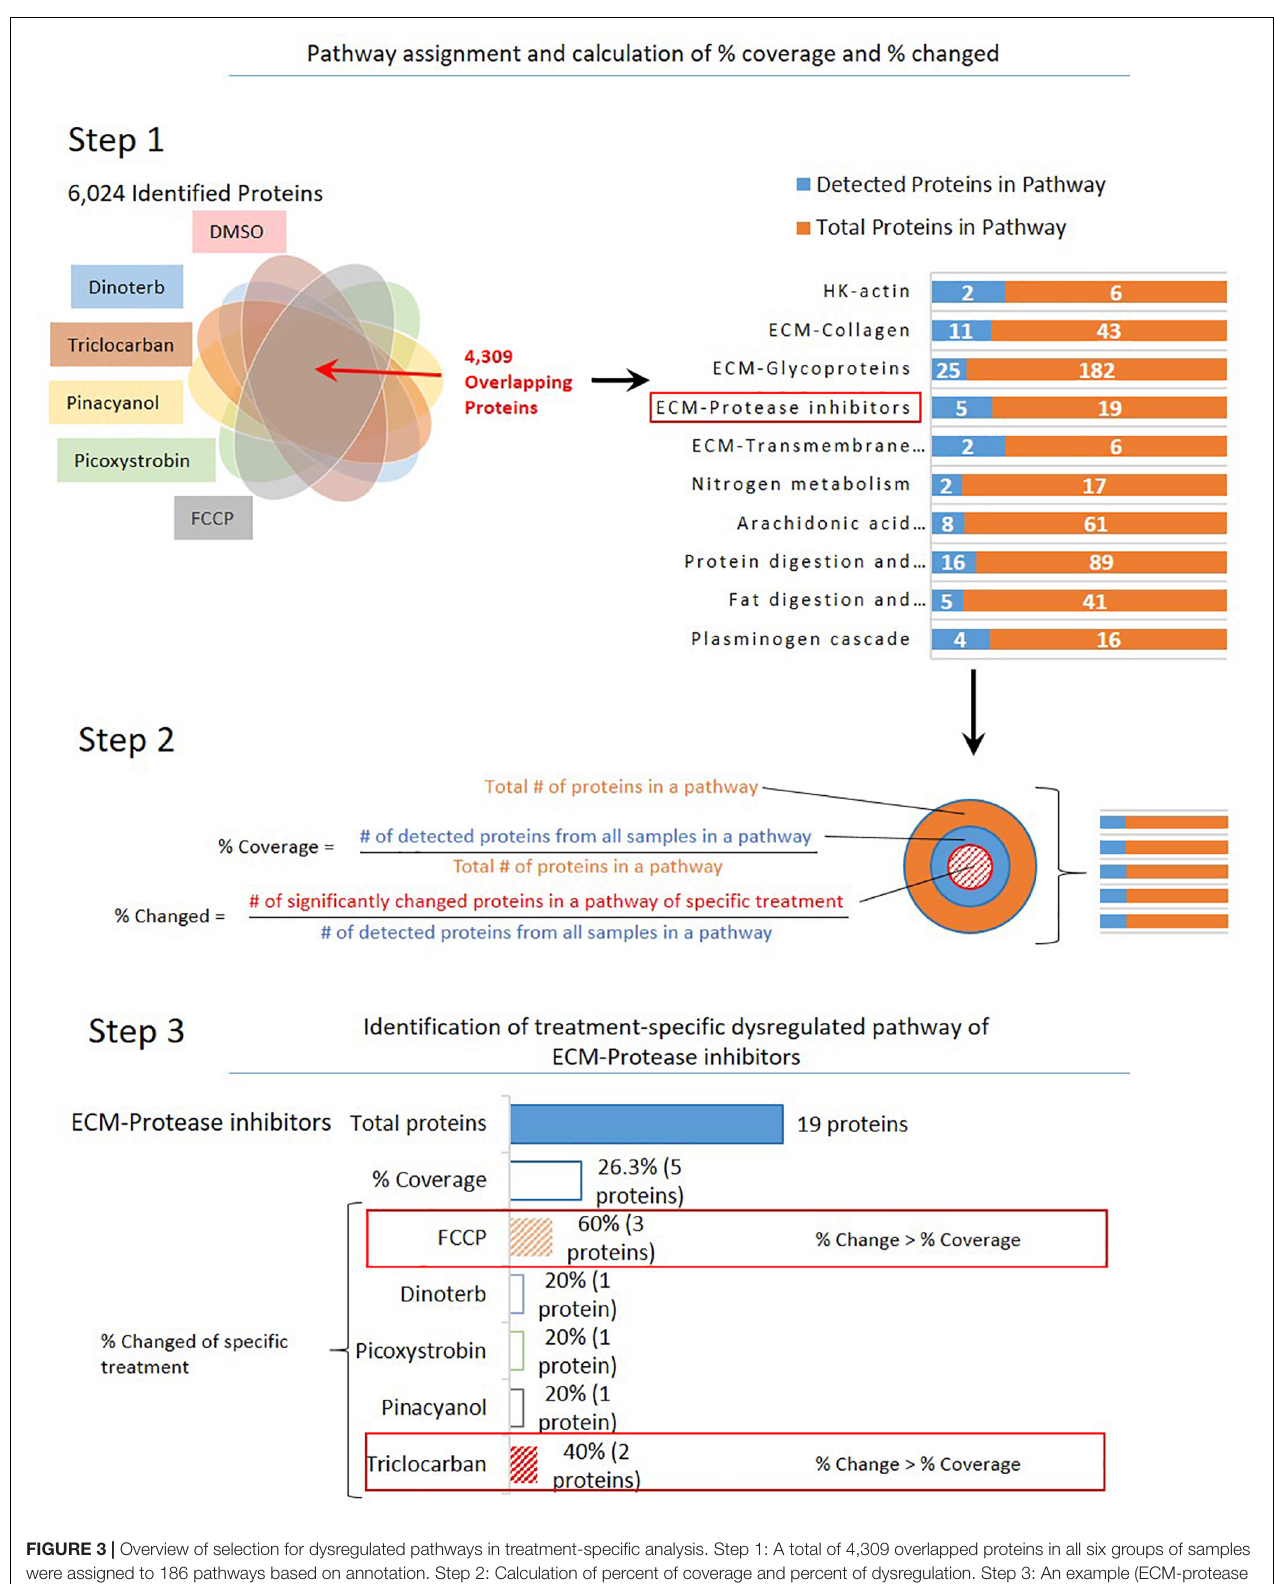
Frontiers in Genetics |